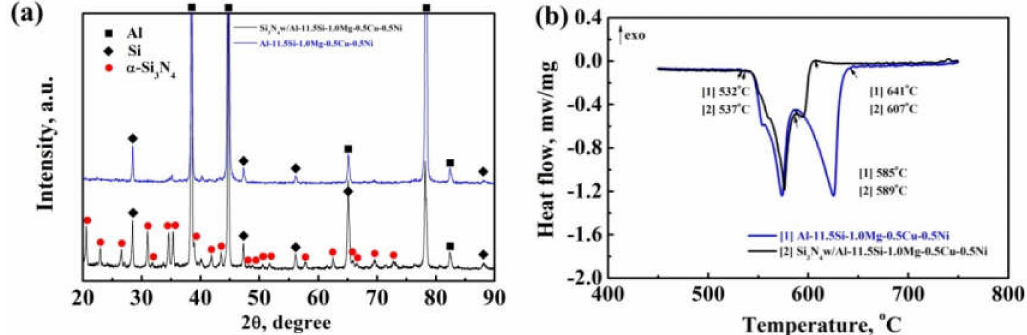
Figure2. ( a )X-raydi ff raction(XRD)patternsand( b )DSCcurvesofSi 3 N 4w / Al-11.5Si-1.0Mg-0.5Cu-0.5Ni composite and matrix, where DSC curves were obtained at a heating rate of 10 K /